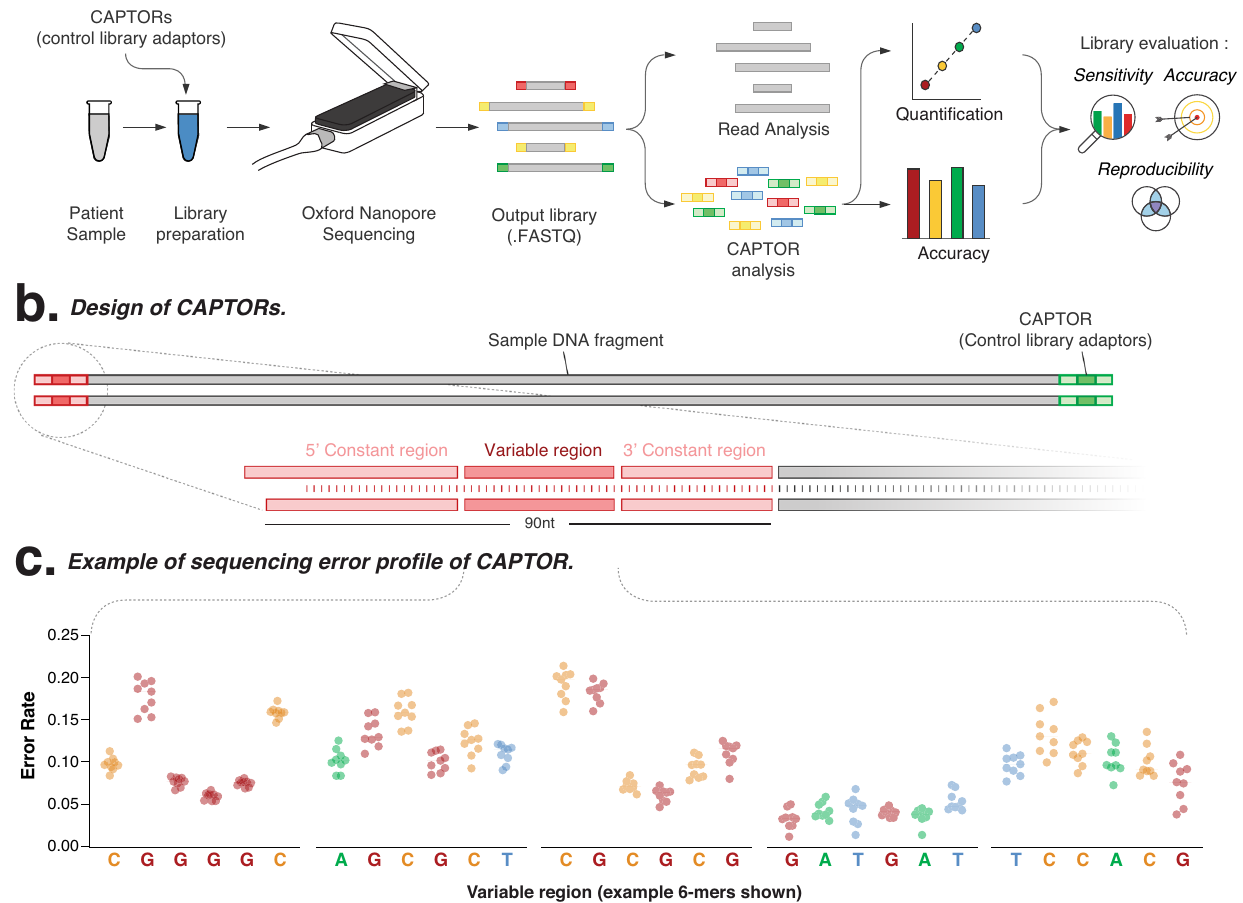
Fig.1|SchematicoverviewofdesignanduseofCAPTORs.a Schematicoverview of work fl ow showing the integration of CAPTORs within the library